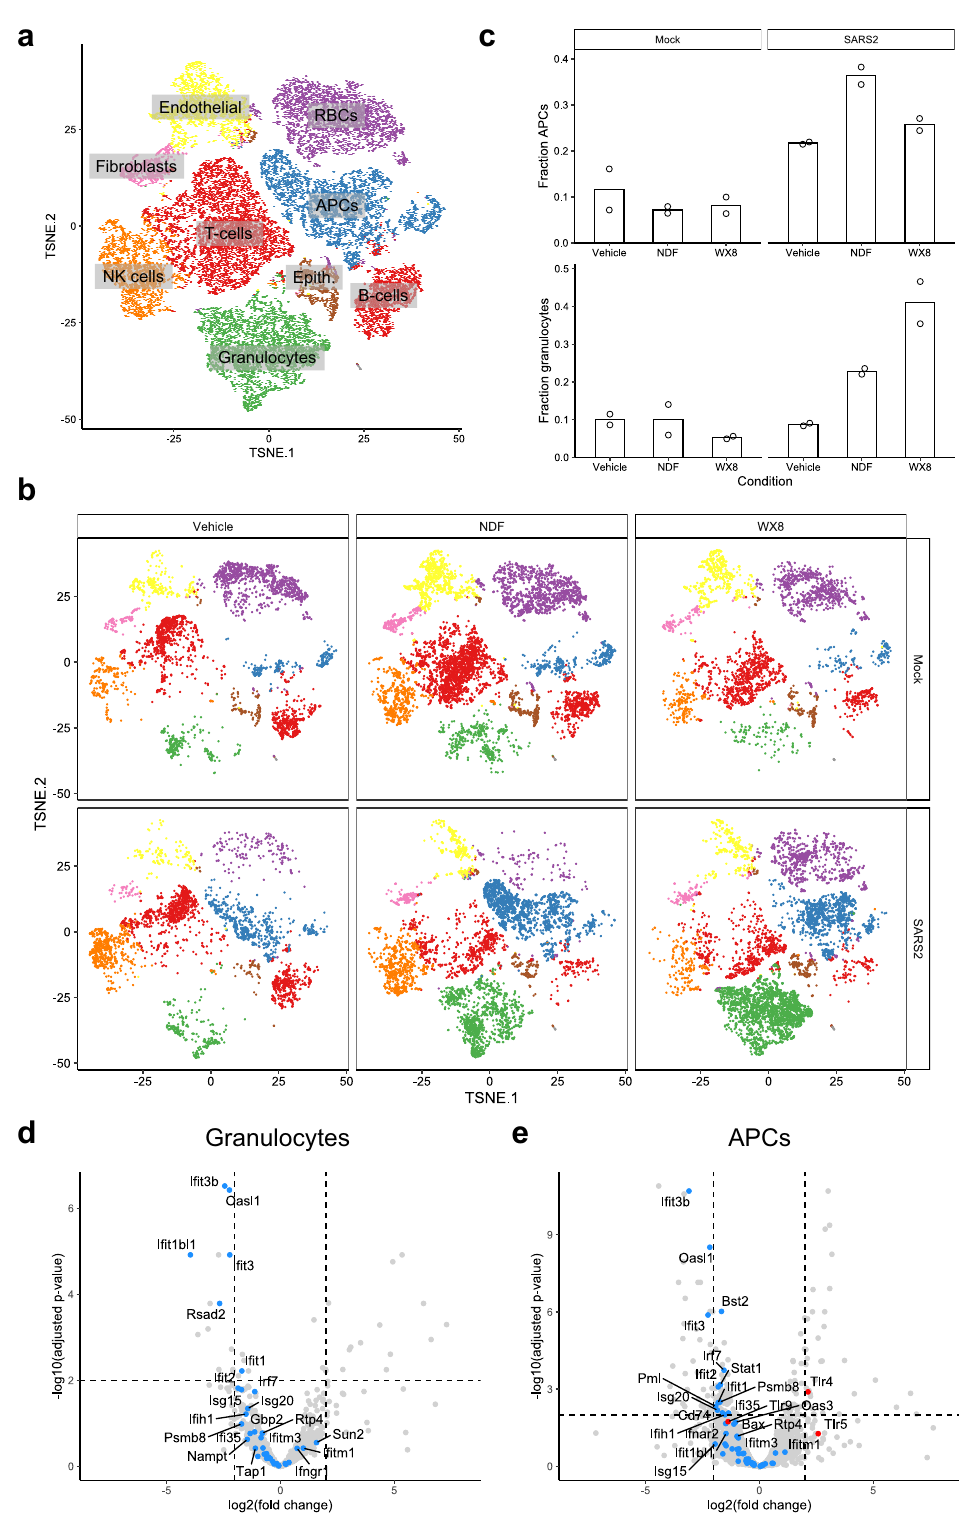
Fig. 4 Single-cell sequencing analysis for PIKfyve inhibitor-treated animals against SARS-CoV-2 infection in mice. a , b t-SNE plot of scRNAseq data for a all samples or b faceted by condition. Cells are colored by cluster (k-means, n = 9), and clusters are labeled by cell type. c Bar plot showing the fraction of cells within the APC (top) and granulocyte (bottom) clusters. d , e Volcano plot showing differentially expressed genes in SARS-CoV-2-infected cells treated with WX8 versus untreated cells in the d granulocyte and e APC clusters. ISGs and genes in the interferon signaling pathway are colored blue (and labeled where space allows). TLRs in ( e ) are colored red. APC, antigen-presenting cells; Epith., epithelial